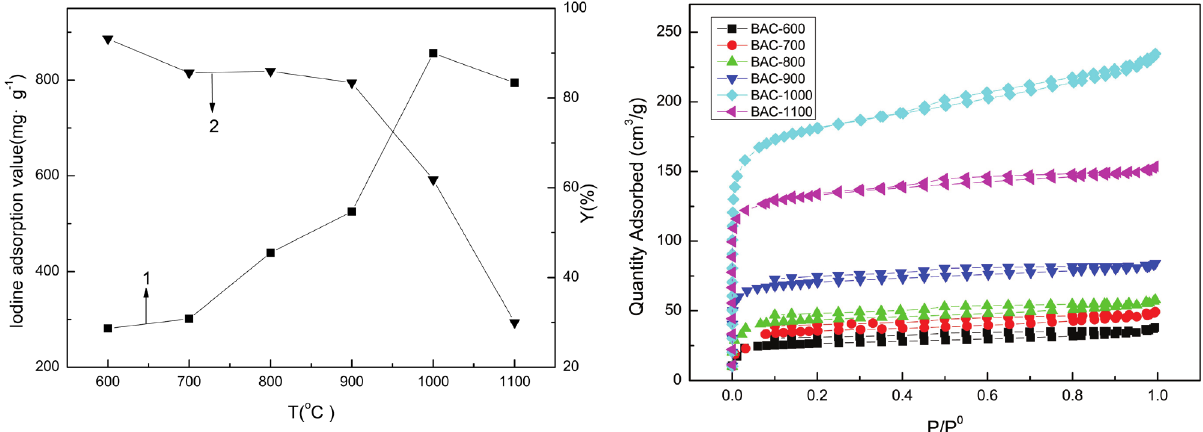
Figure 2: The effect that the activation temperature had on the iodine adsorption value and the BAC yield.